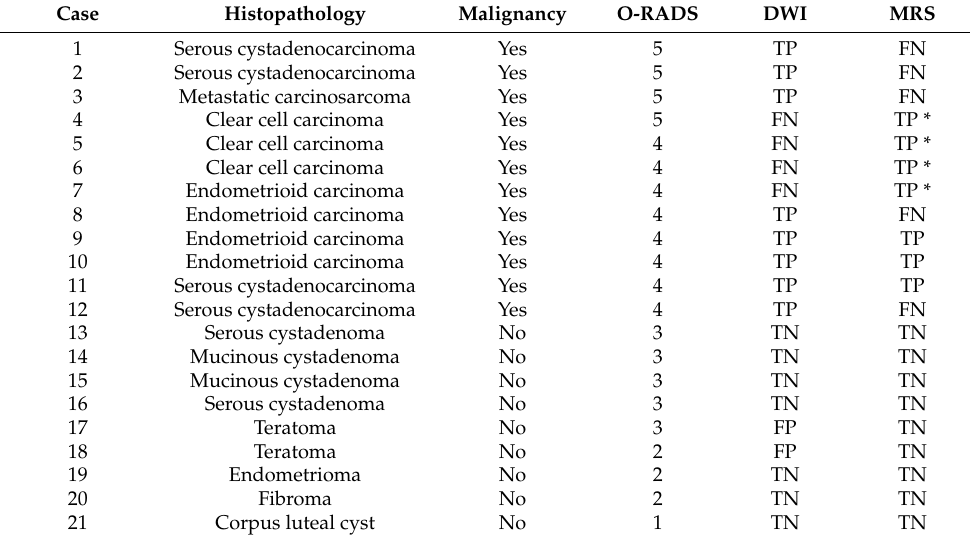
Table 3. The complementary role of DWI and MRS in characterizing malignant vs. benign ovarian tumors.